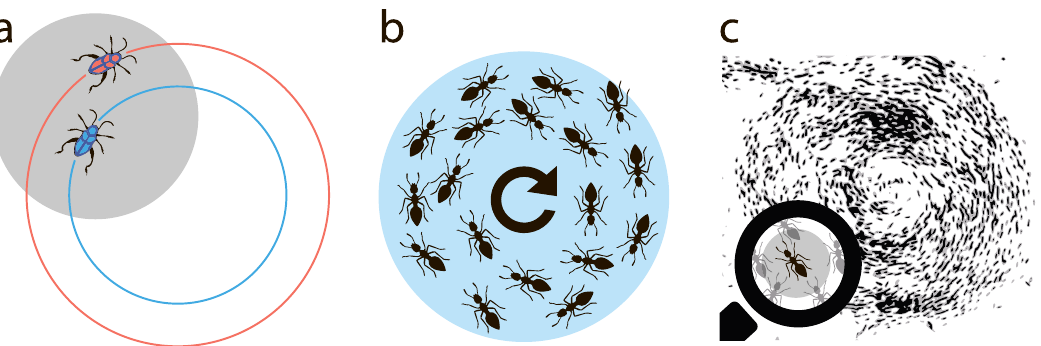
Figure 1. ( a ) Illustration of the escort problem—the leader moves independently on the outer circle, while the follower tries to reside within the comfort zone (shown shaded). ( b ) Illustration of the swirling motion in a swarm. It emerges spontaneously. The comfort zone w.r.t. the center of the swarm is shown (shaded). ( c ) Sketch of the swirling motion in a large colony of insects (ants); the individual comport zone is zoomed. Similar patterns are observed in nature, see e.g. 38